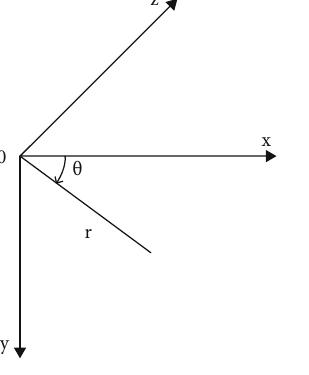
Figure 2: Coordinate